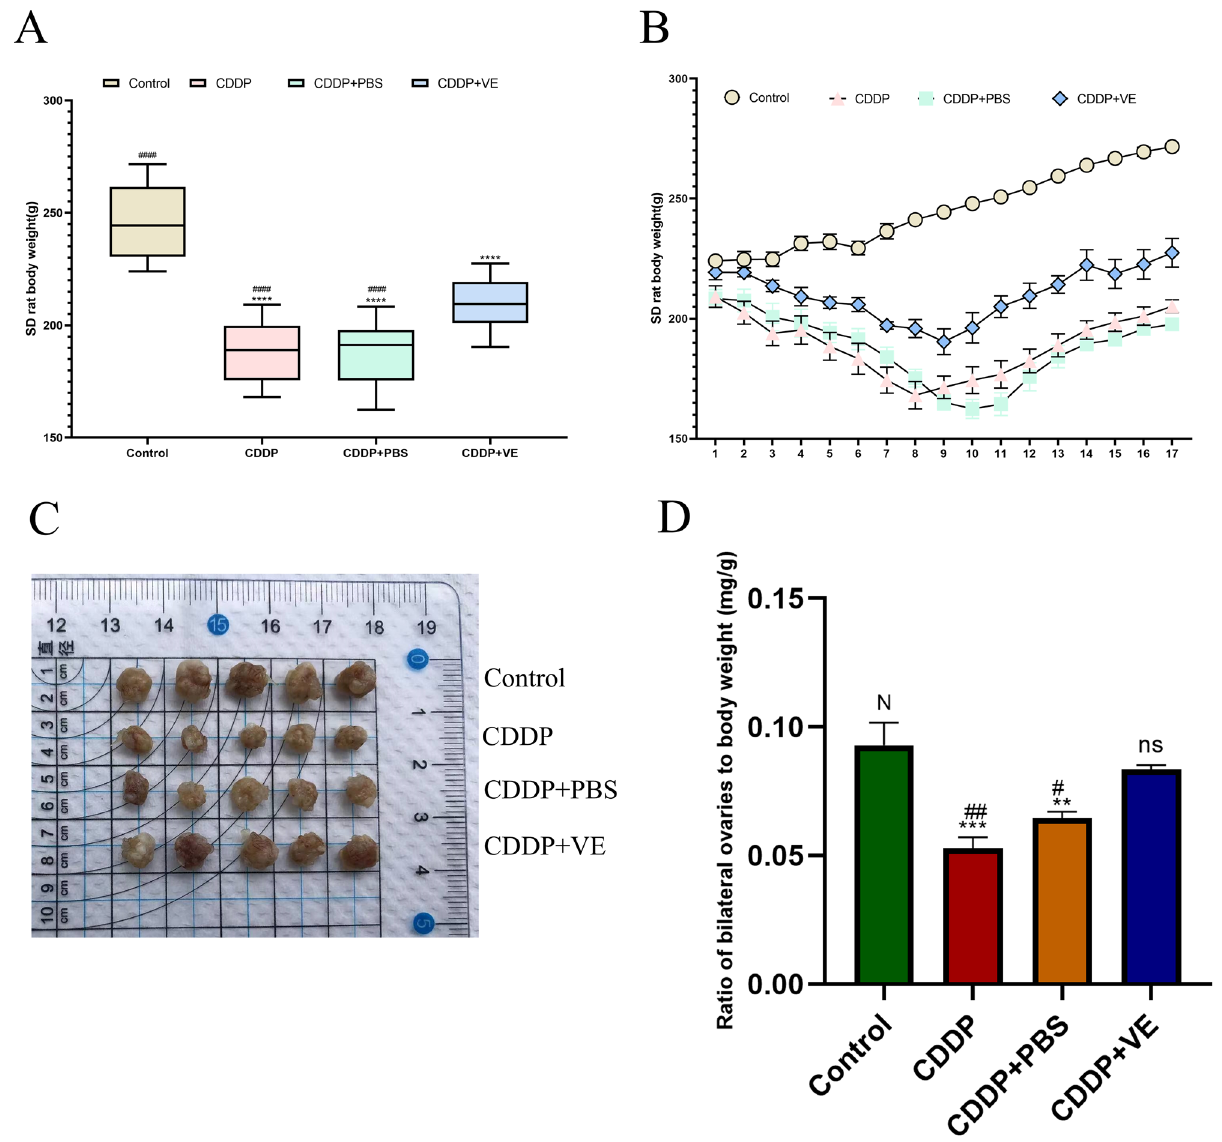
Figure 1. Body and ovary weights of rats. ( A , B ) Body weight changes trend of rats in each group. ( C , D ) Ovarian size and the ratio of bilateral ovaries to body weight in each group. Data are expressed as the means ± SEM. n = 20, ns, * versus control, * P < 0.05, ** P < 0.01, *** P < 0.001 and **** P < 0.0001, ns indicates no statistical significance. N, # versus CDDP + VE, # P < 0.05, ## P < 0.01, ### P < 0.001 and #### P < 0.0001, N indicates no statistical